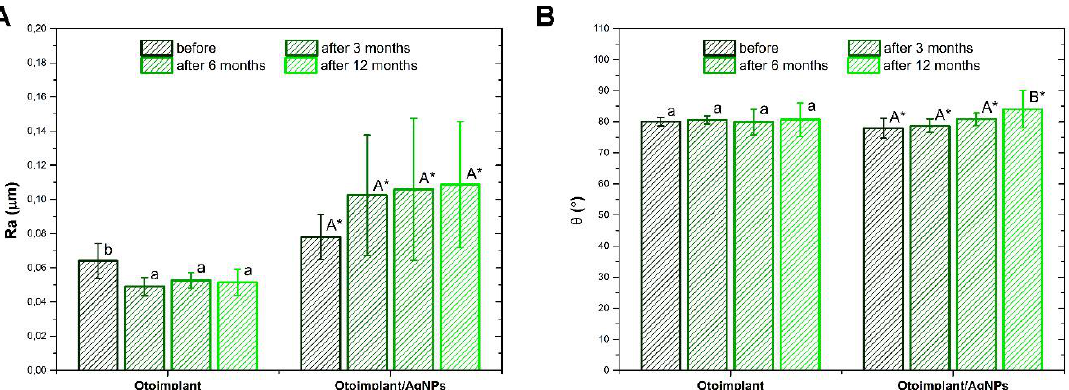
Figure 2. Surface properties of the Otoimplant and Otoimplant/AgNPs before and after 3-, 6-, and 12-month incubation in deionized water: average roughness Ra ( A ) and static water contact angle ( B ). Statistically significant differences ( p < 0.05) between specific incubation times are marked a–b for Otoimplant and A–B for Otoimplant/AgNPs, respectively. Statistically significant differences ( p < 0.05) between Otoimplant and Otoimplant/AgNPs at specific incubation time are marked *.